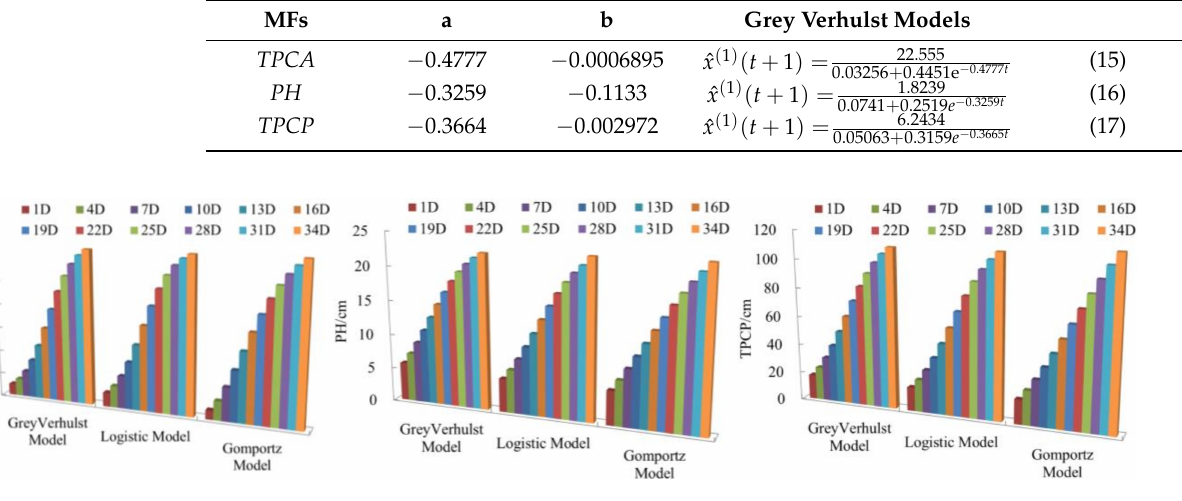
Figure 6. The Gompertz, Logistic and grey Verhulst model predictions of changes in TPCA , PH and TPCP over time.